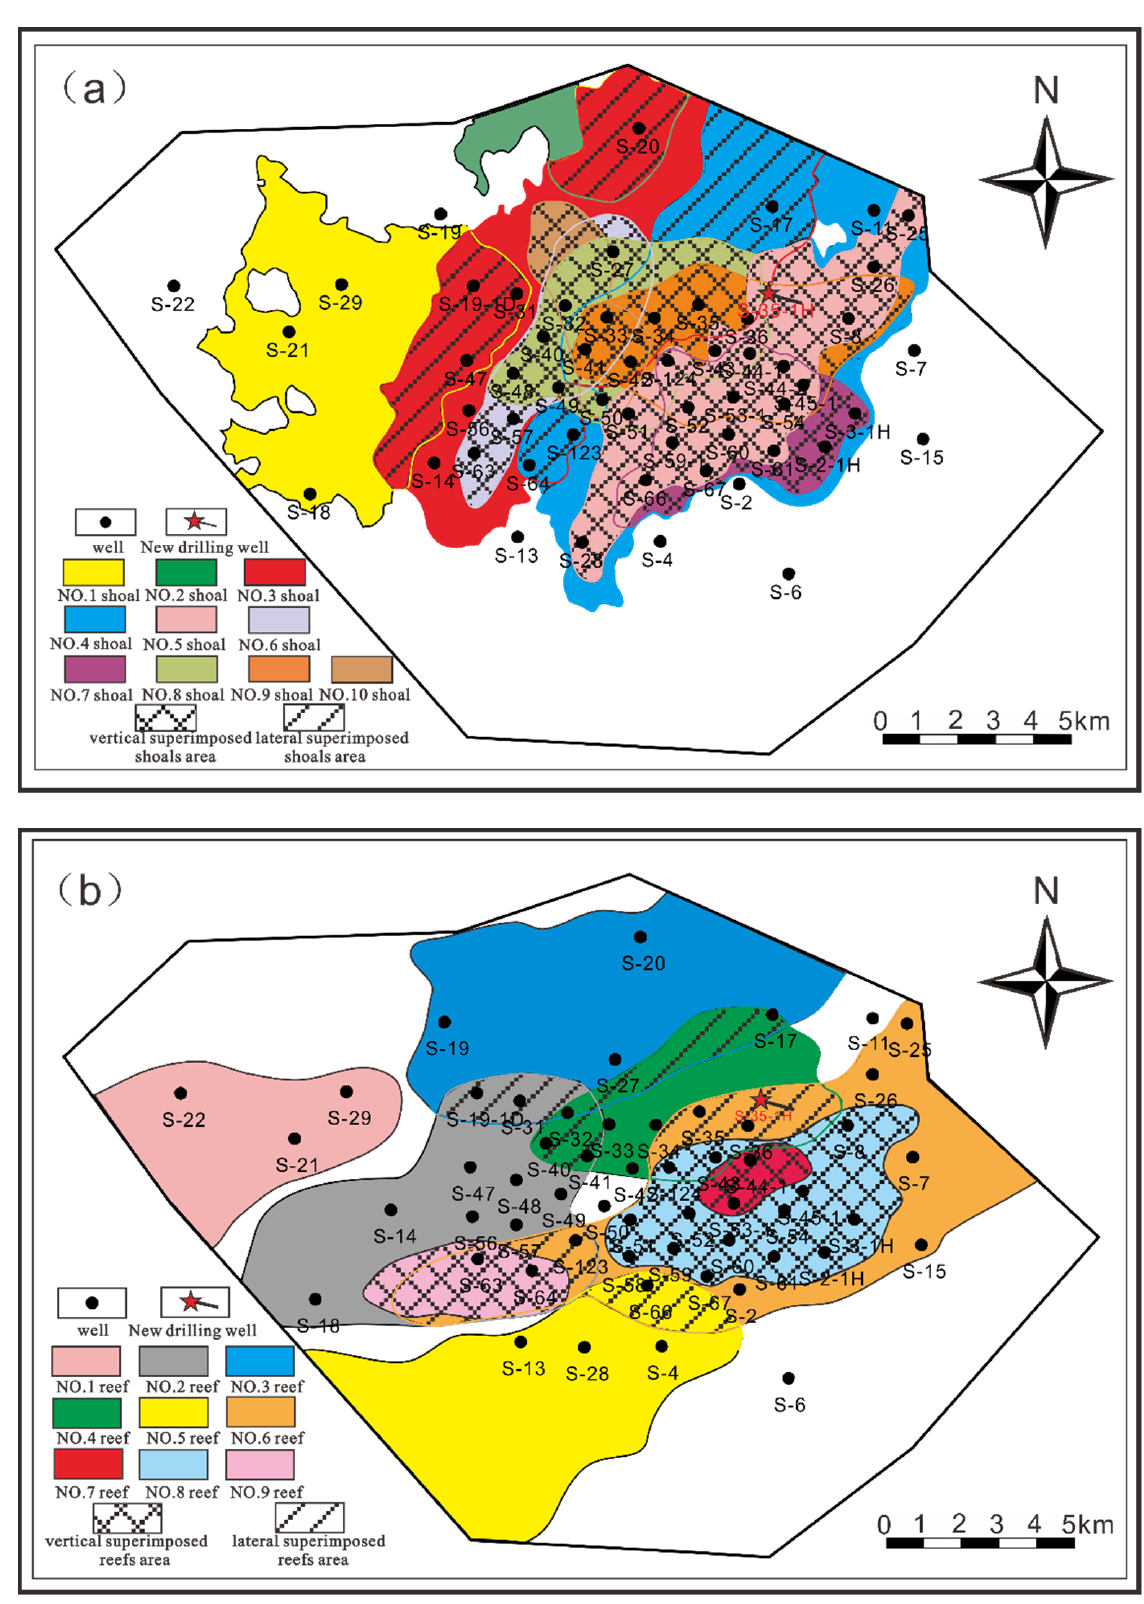
Figure 6. ( a ) The distribution characteristics of a single shoal body in XVp2 layer; ( b ) the distribution characteristics of a single reef body in XVm4 layer.